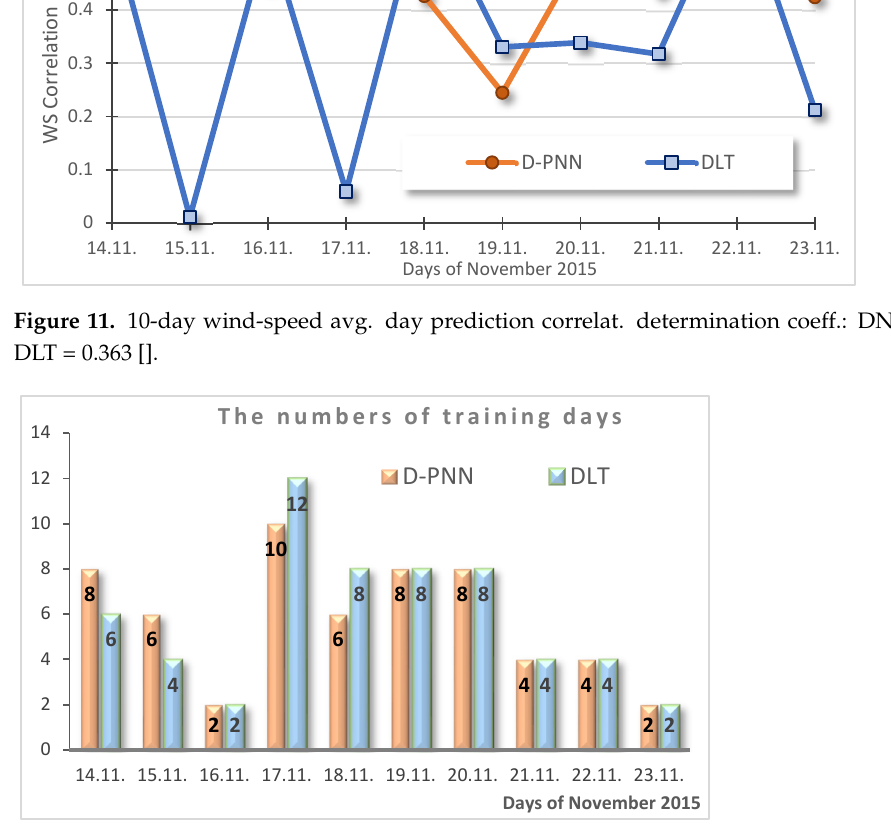
Figure 12. The predetermined initial numbers of the trainable data day series are re-evaluated for selected pattern similarity in the development of solar radiation models.